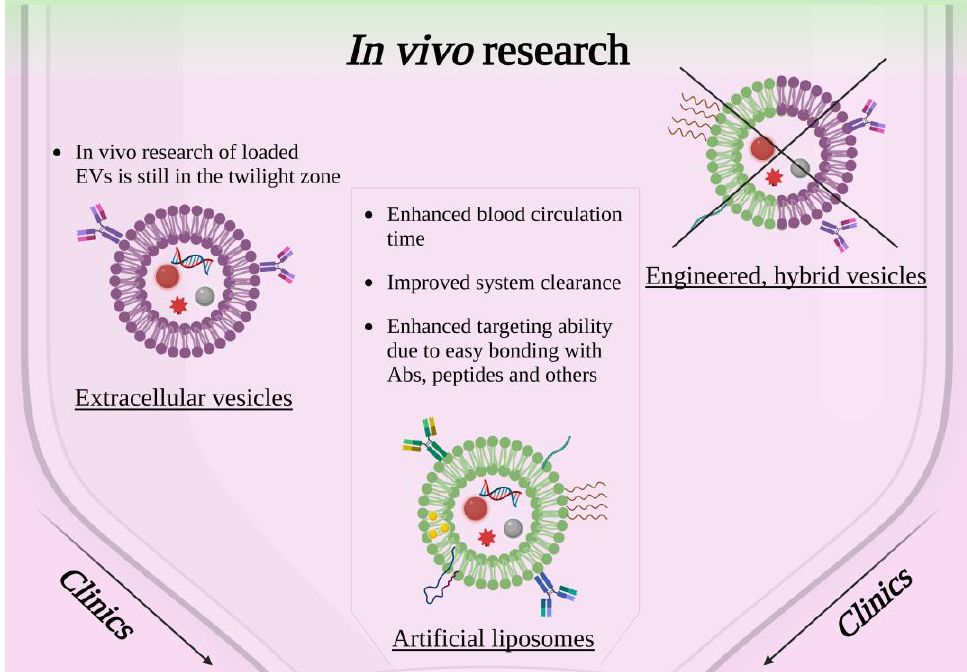
Figure 3. Scheme showing the current panorama of in vivo research involving solid-state nanopar- ticles enclosed in lipidic-based shell, extracellular vesicles or engineered hybrid vesicles. Created with BioRender.com, accessed on 26 October 2022.